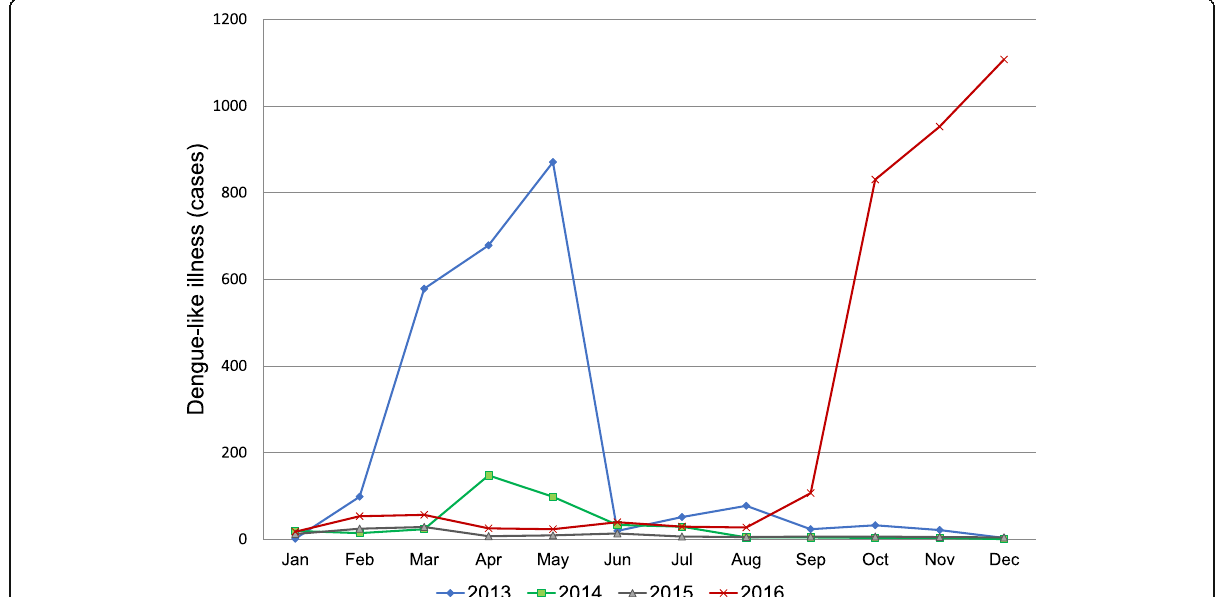
Fig. 2 The number of cases detected in Honiara during the sentinel clinic surveillance from 2013 to